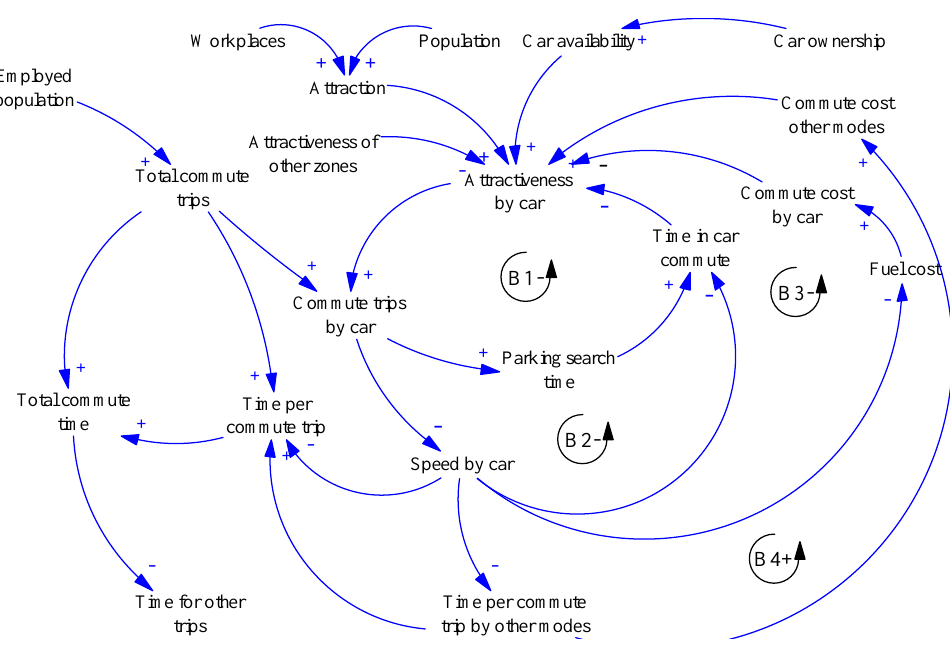
Figure 11. CLD for the transport model – commute trips by car in MARS Apart from developing the CLD structure we also implemented enhancements to the model including representation of over-crowding, congestion in the off-peak period, representation of a fourth heavy rail mode, the impact of bus quality factors and awareness campaigns. These improvements are reported in Shepherd et al.,